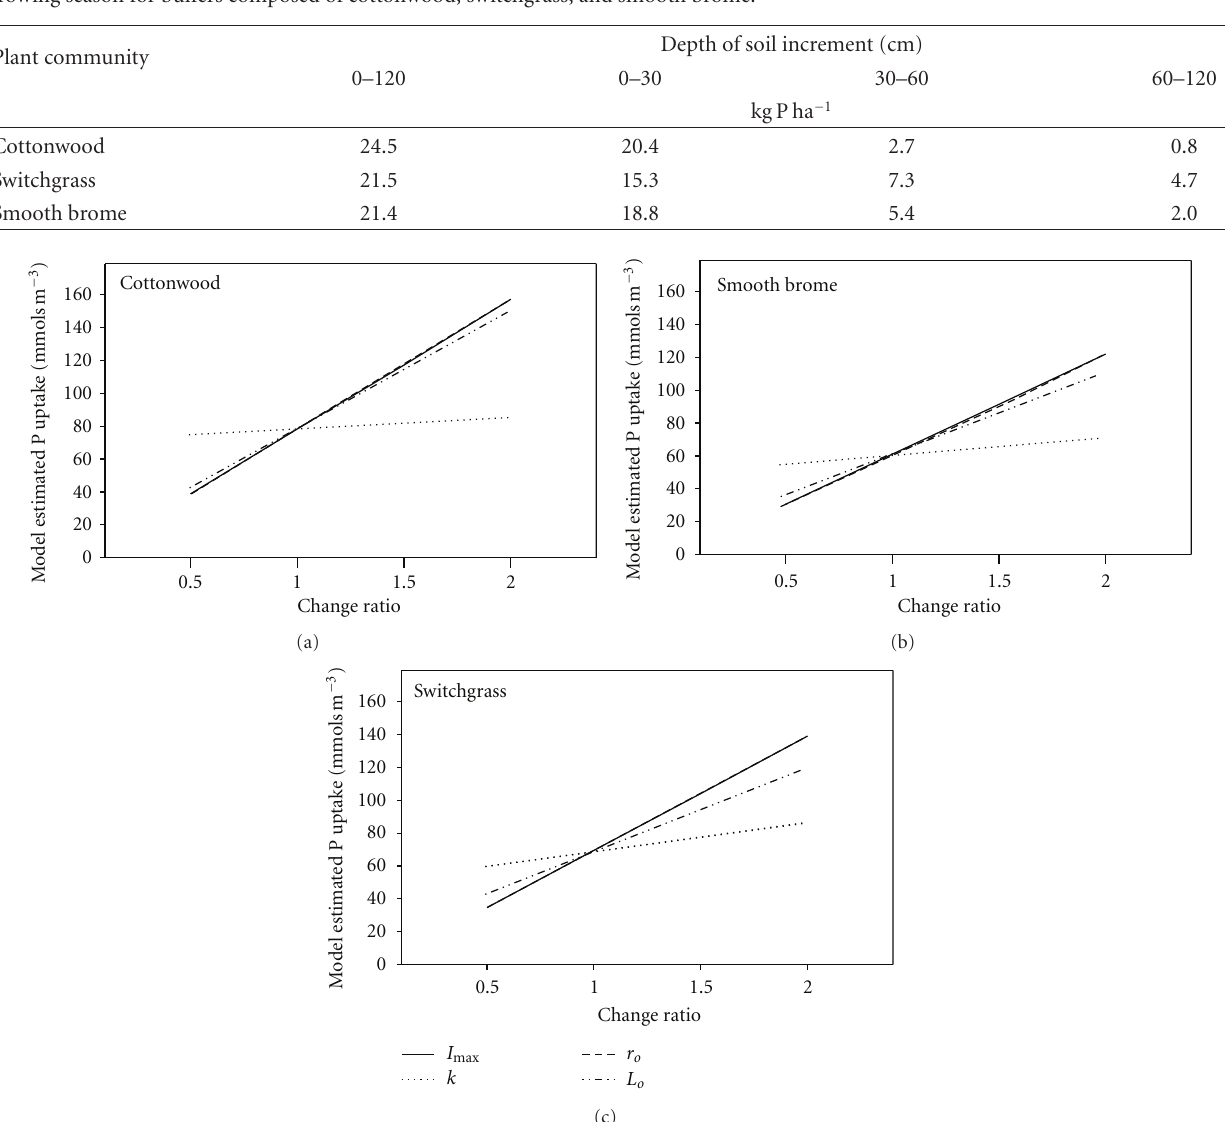
Table 5: NST 3.0 model estimates of phosphorus uptake in kilograms per hectare for four depth increments at the end of a 126 d simulated growing season for bu ff ers composed of cottonwood, switchgrass, and smooth brome.